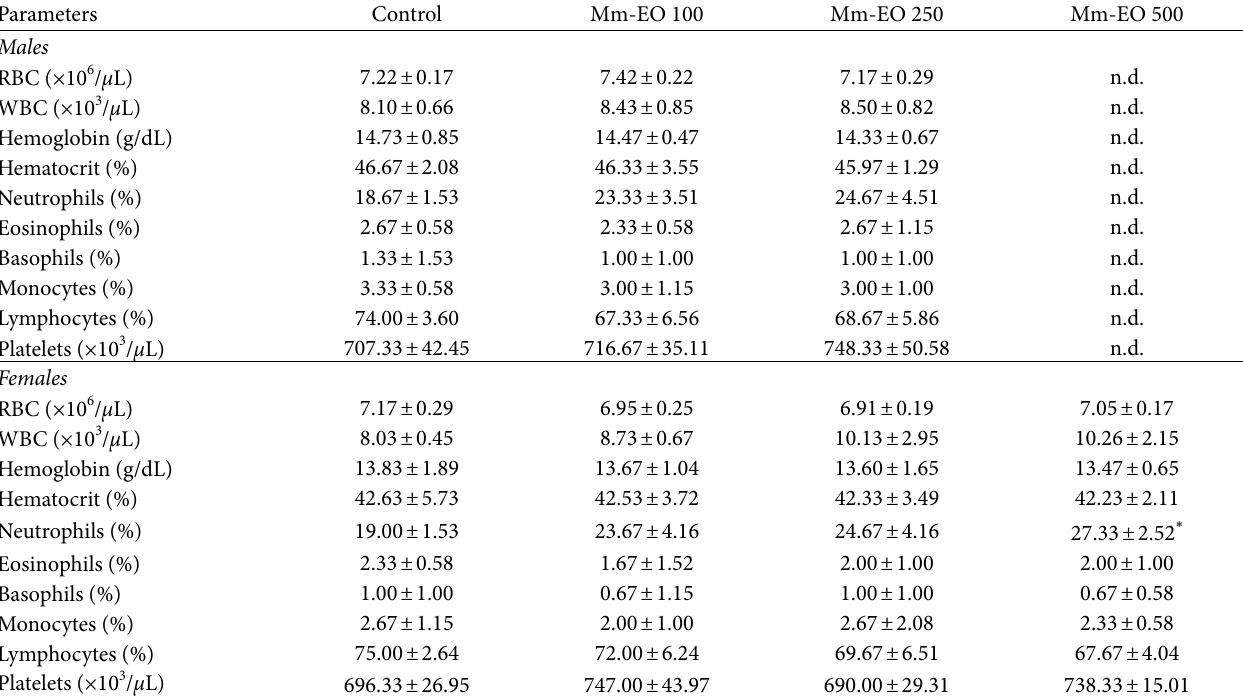
Values are expressed as Mean ± SD, significance when compared with control ∗ ( 𝑝 < 0.05 ). One-way ANOVA followed by Tukey test. RBC, Red blood cell; WBC, White blood cell. n.d., not determined because rats died in the first week of